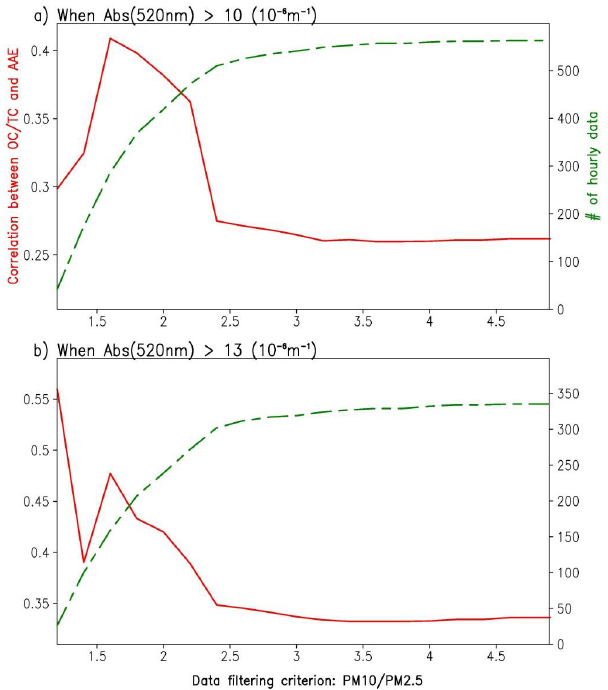
Fig. 8. Correlation between OC/TC and AAE, as a function of the Figure 8. Correlation between OC/TC and AAE, as a function of the data filtering criterion data filtering criterion based on PM 10 /PM 2 . 5 . See Fig. 5 for the based on PM10/PM2.5. See Fig. 5 for the discussion of the filtering criterion. Also shown is the discussion of the filtering criterion. Also shown is the number of number of hourly data corresponding to data filtering criterion. hourly data corresponding to data filtering criterion.